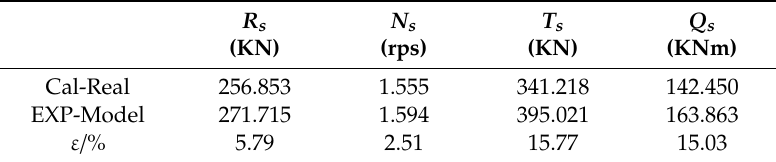
Table 6. Calculated values for full ship and extrapolated values for